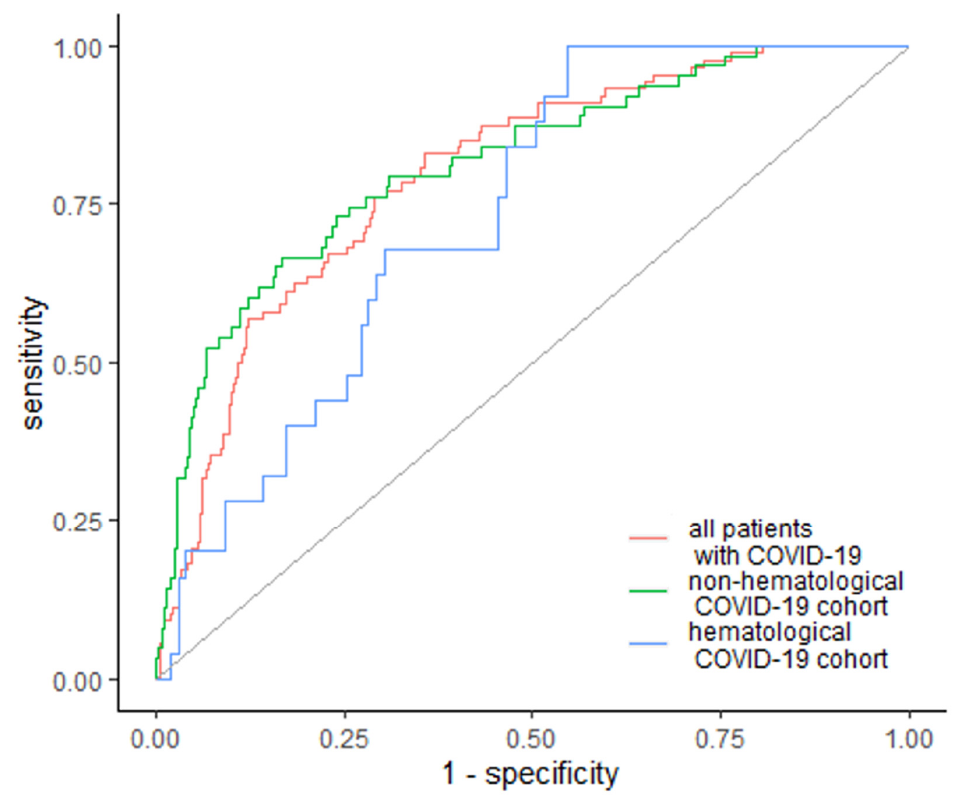
Figure 1. EASIX as a predictor of acute renal failure. Diagonal grey line represents random classifier (false positive rate = true positive rate).